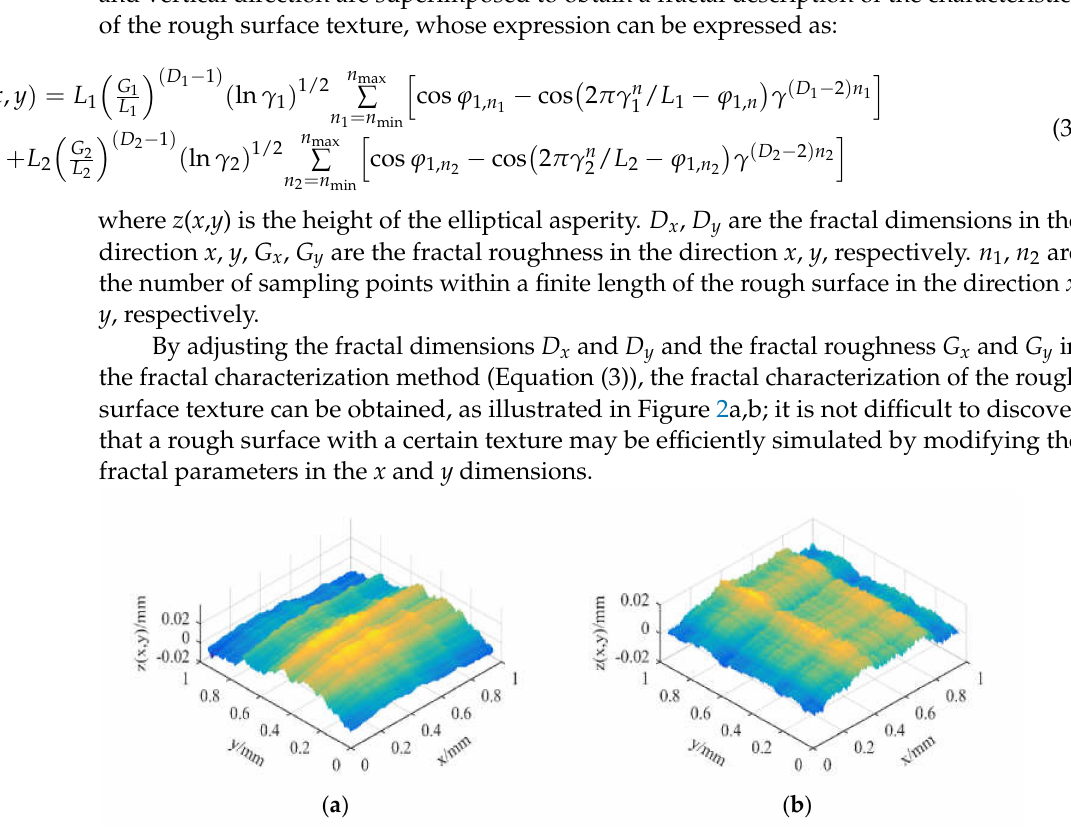
Figure 2. Fractal characterization of rough surfaces with different processing texture features: ( a ) G x = 1.0 × 10 − 11 m, G y = 1.0 × 10 − 9 m, D x = 1.6, D y = 1.3; ( b ) G x = 1.0 × 10 − 9 m, G y = 1.0 × 10 − 11 m, D x = 1.3, D y =